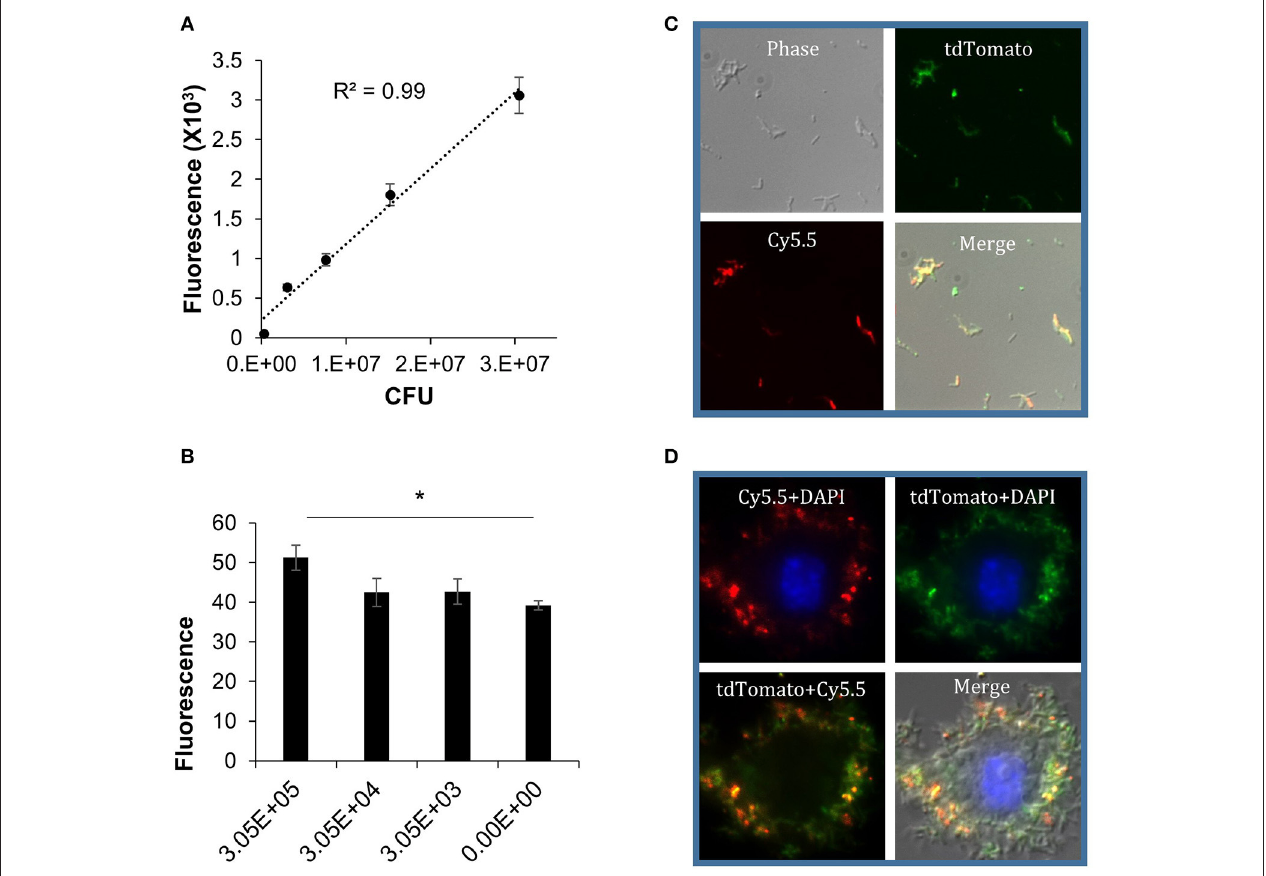
FIGURE 6 | DLF-1 labeling of dormant Mtb cultured in Wayne model. (A) Correlation between fluorescence measured with DLF-1 wavelengths and bacterial numbers of dormant Mtb . Mtb was labeled with DLF-1 at 100 nM. (B) Threshold detection of DLF-1 labeling dormant Mtb in culture. * P < 0.05. (C) DLF-1 (100nM) labeling dormant Mtb smeared on slides, and imaged with a fluorescent microscope. (D) Microscopy images of the DLF-1 (100 nM) labeled dormant Mtb strain carrying a genome-integrated tdTomato gene inside of THP-1 macrophages. Red, Cy5.5; Green, tdTomato; Blue, DAPI stained nuclei.